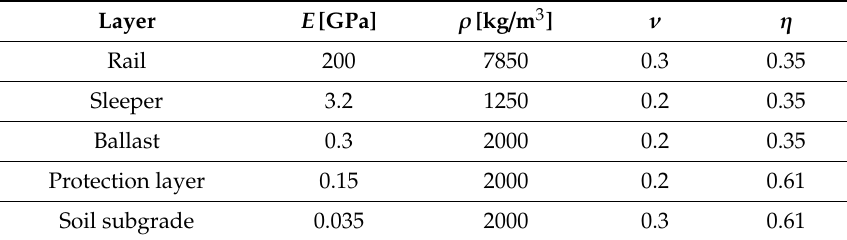
Table 2. Material parameters used in the FE model.